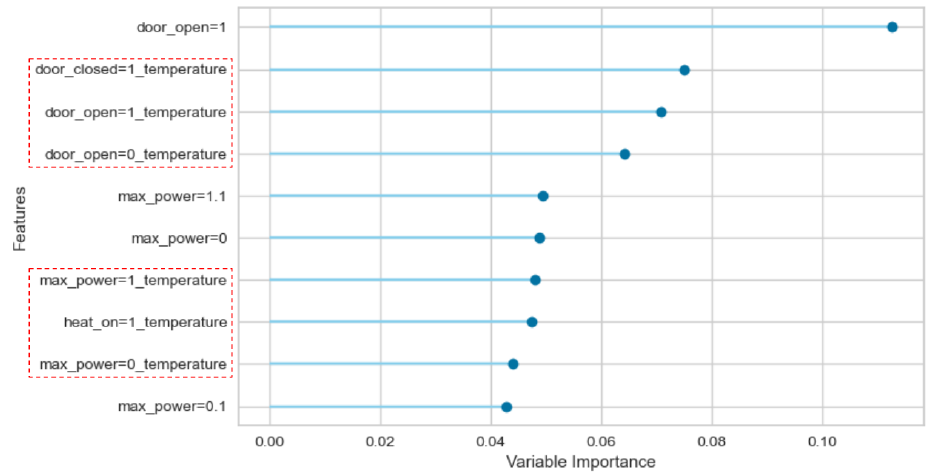
Figure 7. Furnace: Feature Importance regarding the PA